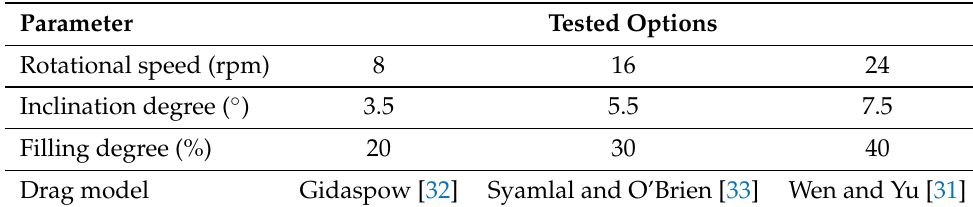
Table 2. Details of the CFD simulated scenarios.